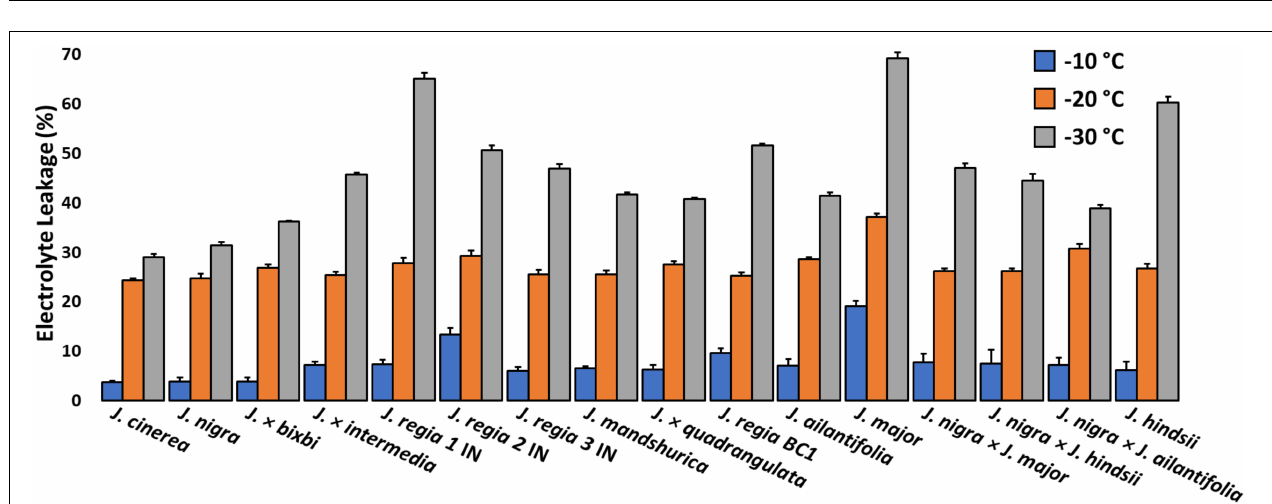
FIGURE 2 | Mean ( ± SE) height and winterkill for studied Juglans species and interspecific hybrids. Heights were measured in winter 2014 and winterkill damage was measured in June 2014. J. regia 1 (California) and J. major (Arizona black walnut) were killed to the ground and did not re-sprout. Winterkill was rated from 1 to 5.